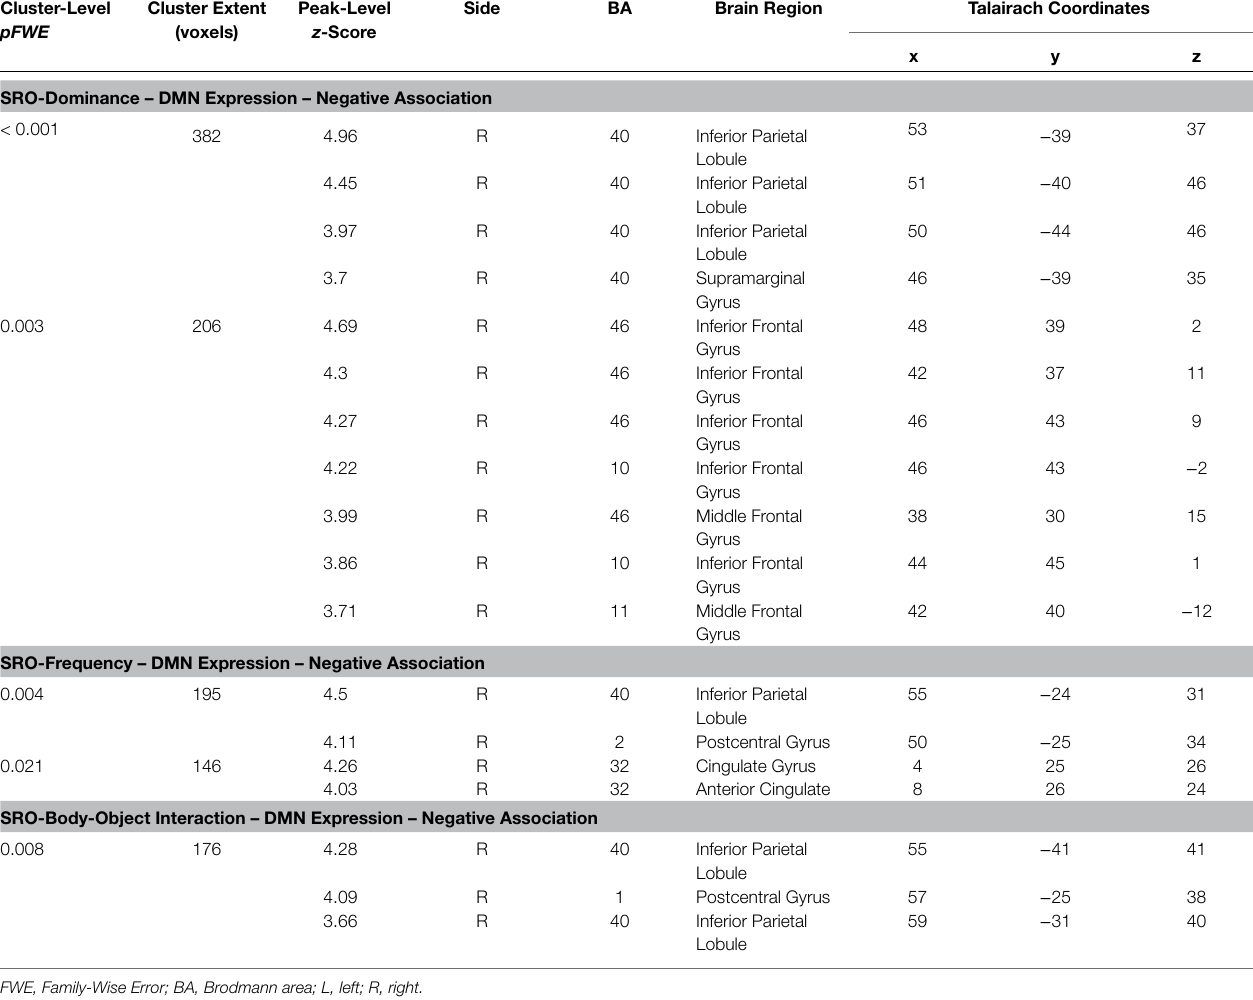
TABLE 2 | Significant findings emerging from the first set of inferential models.